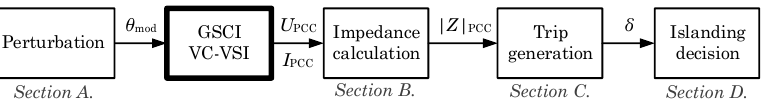
Figure 12. Impedance measurement operation diagram.